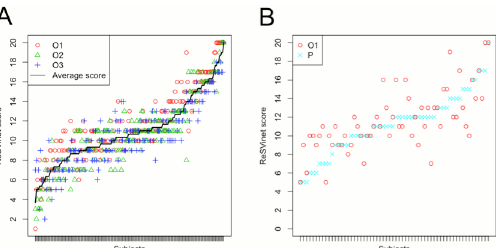
Fig 1. Comparison of results obtained (A) by the three observers, and (B) by the parents and one of the observers. In graph A: O1- Results obtained by observer 1. O2- Results obtained by observer 2. O3- Results obtained by observer 3. In graph B: O1- Results obtained by observer 1. P — Results obtained by the